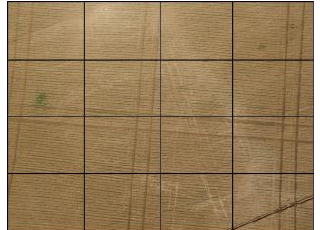
Figure 4. example for a 4*4 grid covering the RGB image